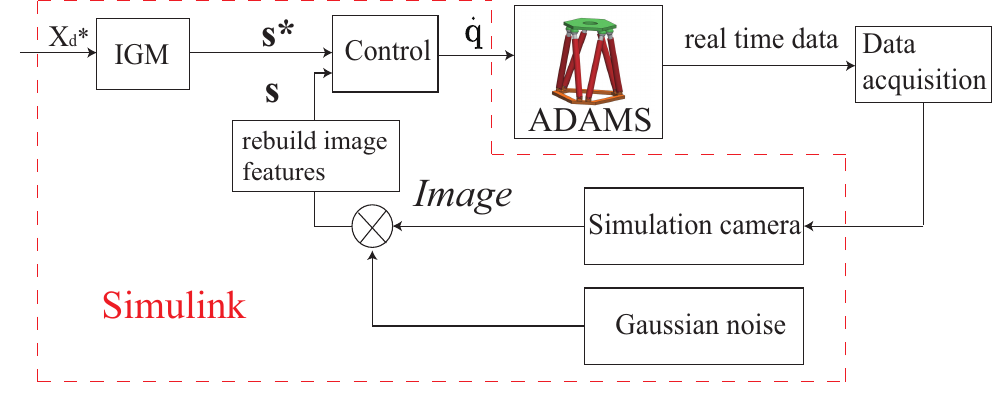
Figure 13. Co-simulation control scheme of Gough–Stewart platform.